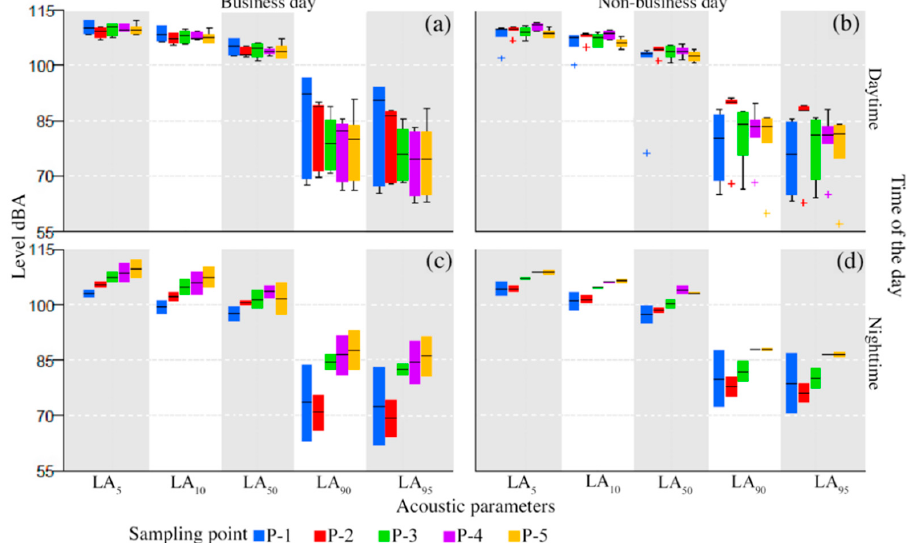
Figure 5. Acoustic indicators (percentiles) for each day of the week, time of day and sampling point. ( a ) Weekday, daytime. ( b ) Weekend, daytime. ( c ) Weekday, night-time. ( d ) Weekend, night-time.